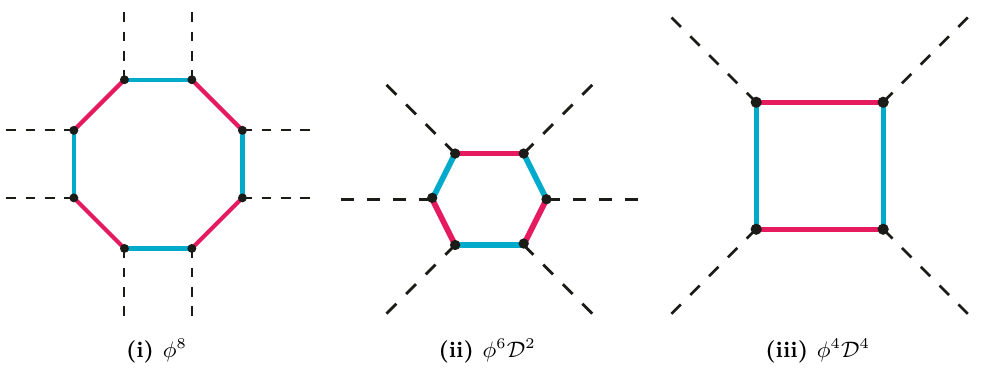
Figure 6. Schematic diagrams revealing heavy-heavy fermion mixing incorporated within (i) φ 8 , (ii) φ 6 D 2 , and (iii) φ 4 D 4 classes of SMEFT